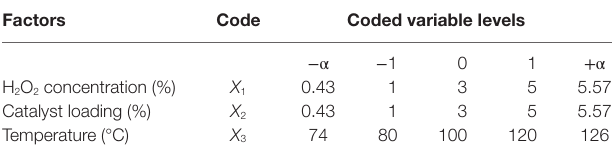
Table 1 | Experimental factors and their coded levels of independent variables for central composite